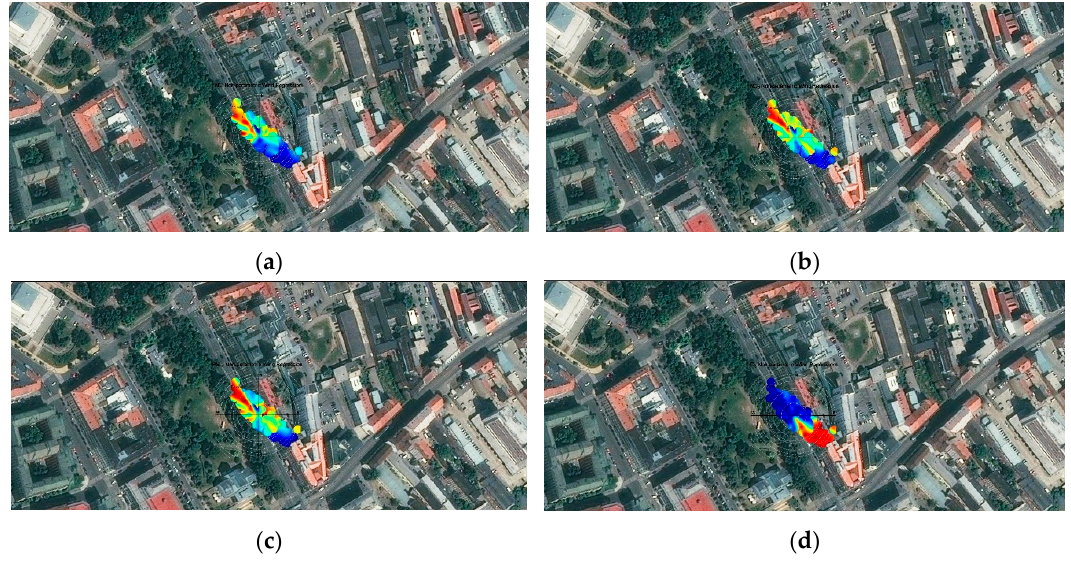
Figure 11. The NO ( a ), NO 2 ( b ), PM 10 ( c ), and O 3 ( d ) concentration relationships to the wind speed and direction at Kolišt ě road; sampling started on 8.11.2019 0:00.